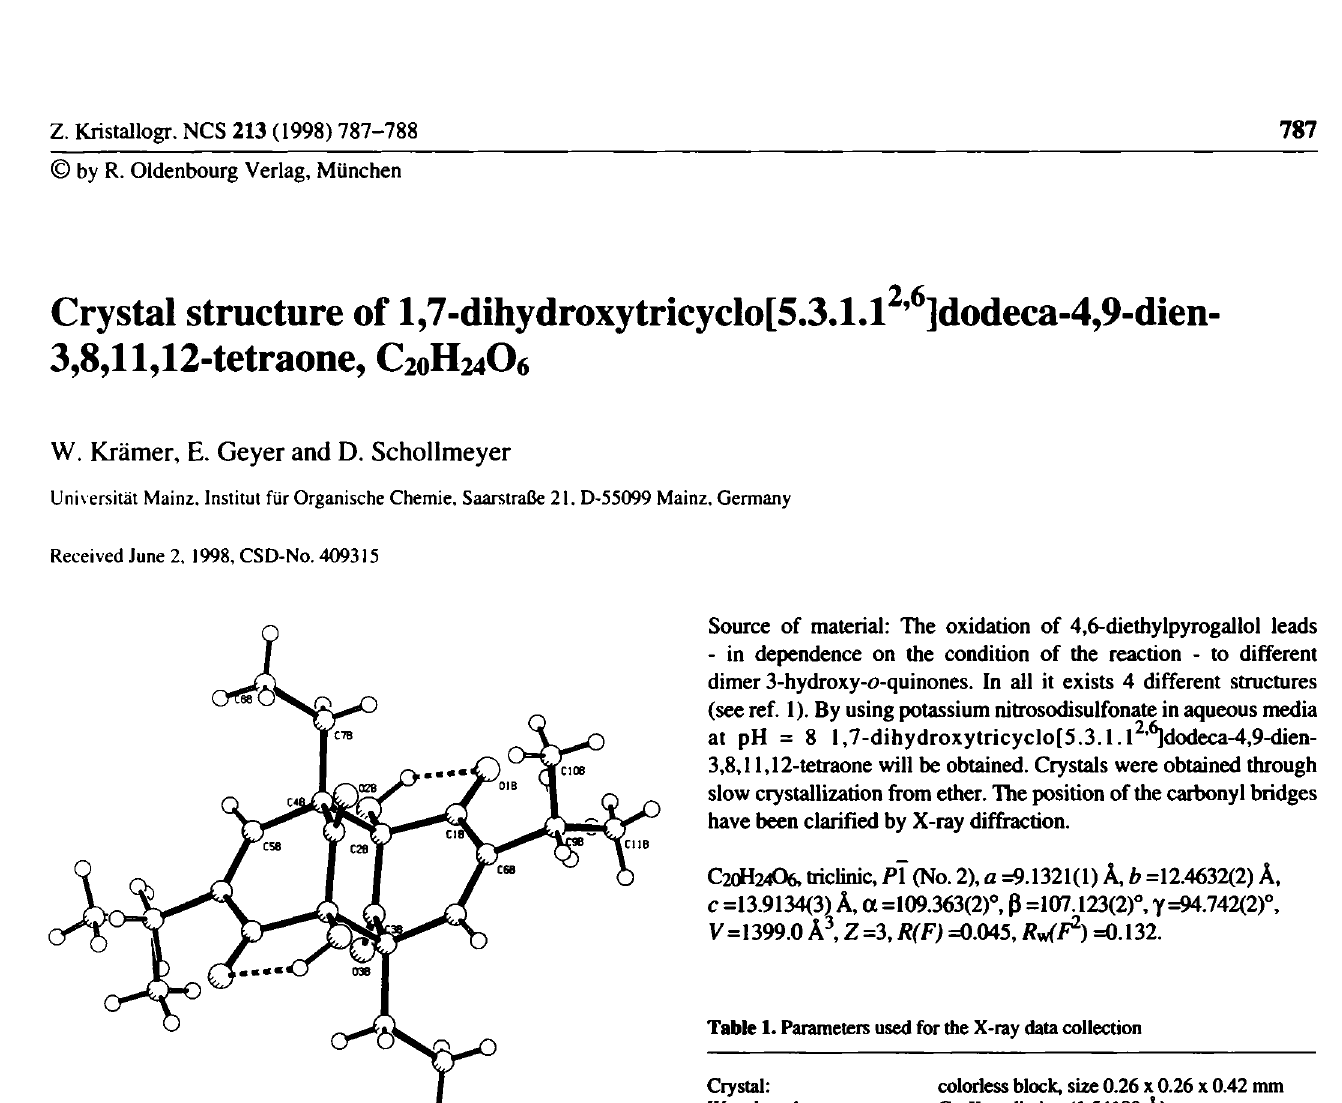
Fig. 1. One of the three independent molecules.